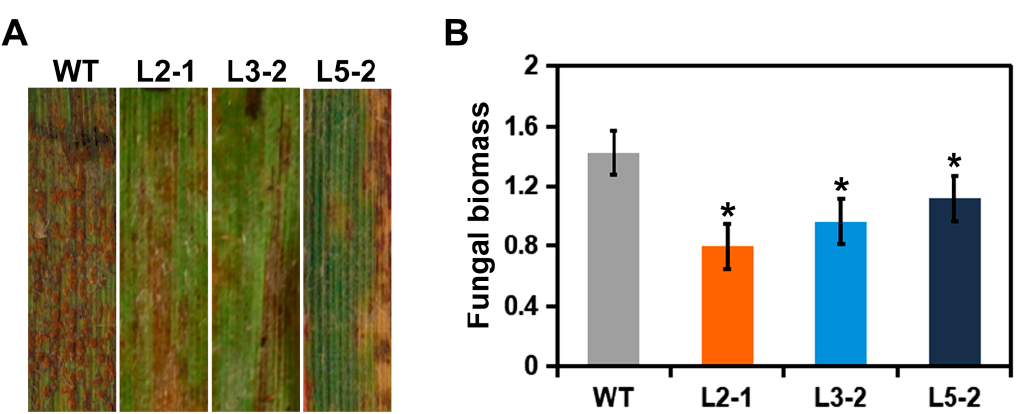
Figure 2. AtSAG101 transgenic plants enhance resistance to Puccinia brachypodii . ( A ) Phenotypic changes in leaves of AtSAG101 transgenic plants challenged with P. brachypodii . ( B ) Biomass of P. brachypodii. Significant differences were determined using Student’s t -test : *, p < 0.05 . WT, wild type plants; L2-1, L3-2 and 5-2, transgenic B. distachyon plants.